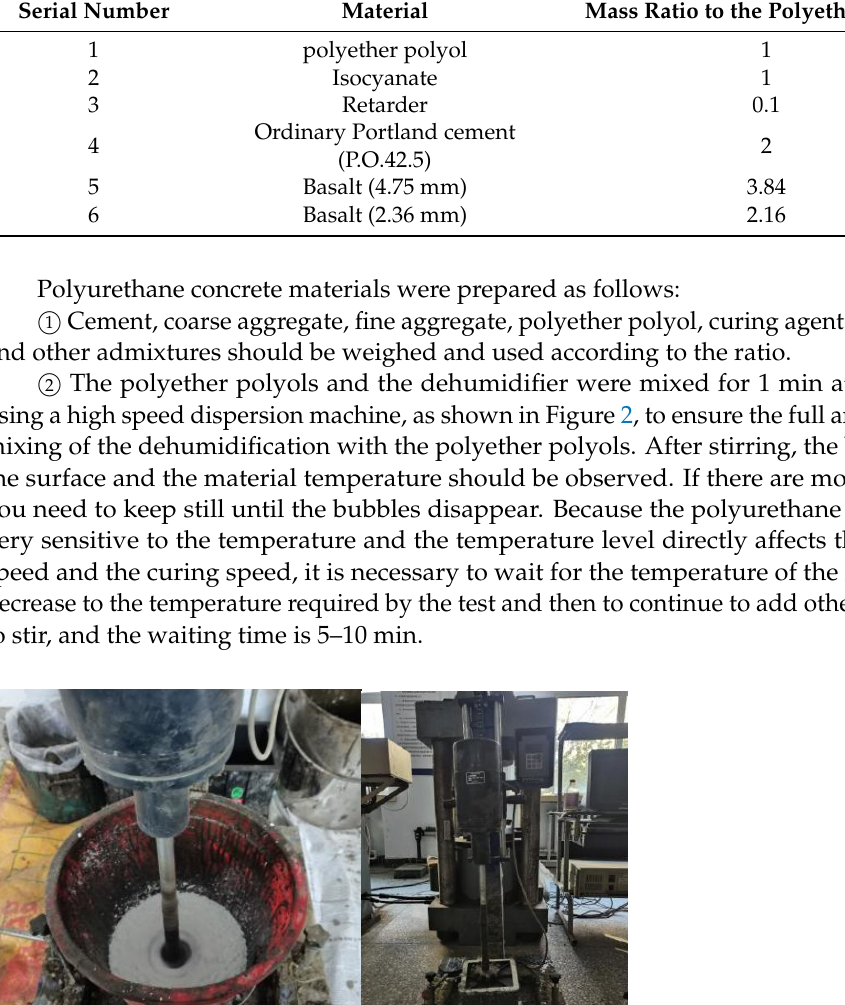
Table 4. Composition of polyurethane concrete.